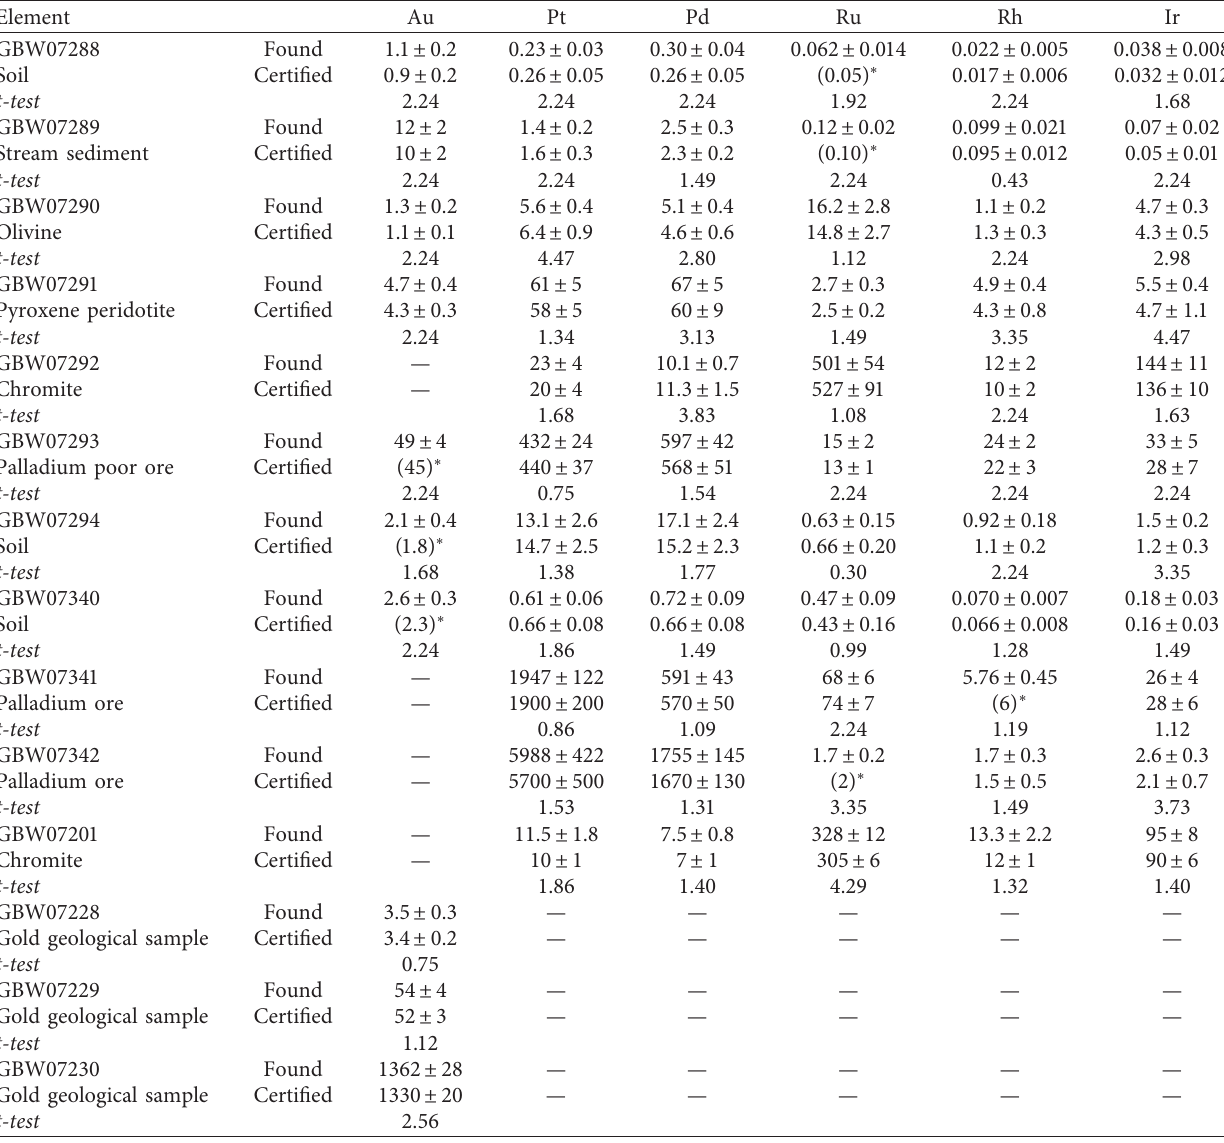
Table 5: Comparison of analytical data and recommended values for Au, Pt, Pd, Ru, Rh, and Ir in certified reference materials samples by the